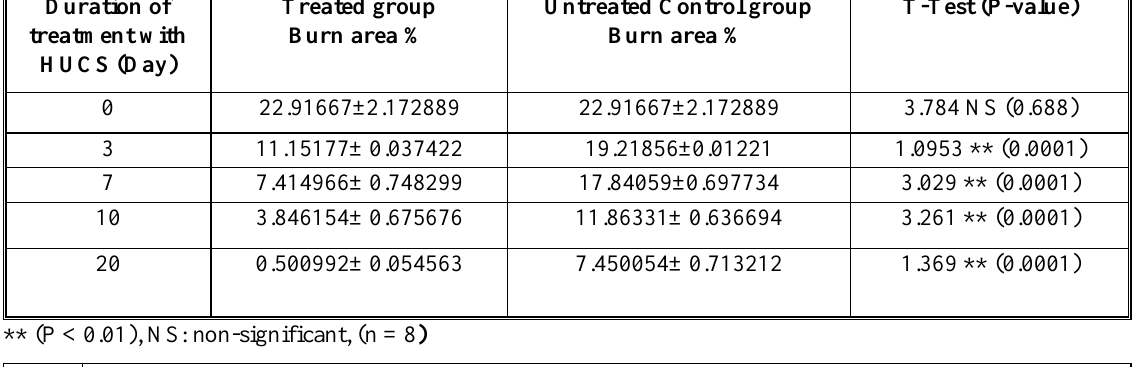
Table 2. Comparative burn area (%) in rabbit groups subjected to scalding by boiling water